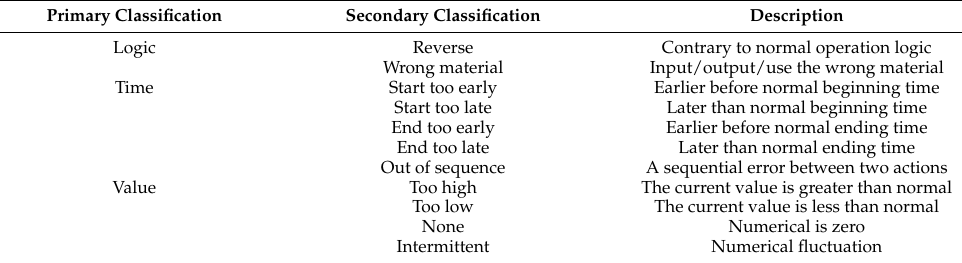
Table 1. Classification of failure deviation.